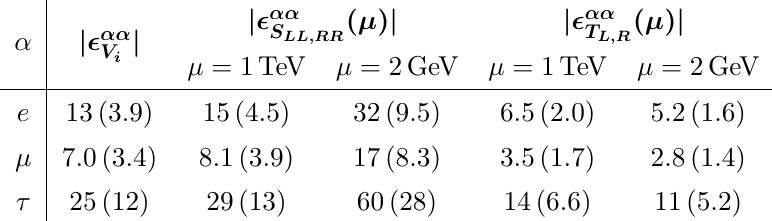
95% CL limits on the neutral-current WCs from pp → e α ¯ e α at the LHC, with i = LL, RR, LR, RL . We also show in parenthesis the naive projections of the expected limits for the HL-LHC (3 ab − 1 ), assuming that the error will be statistically